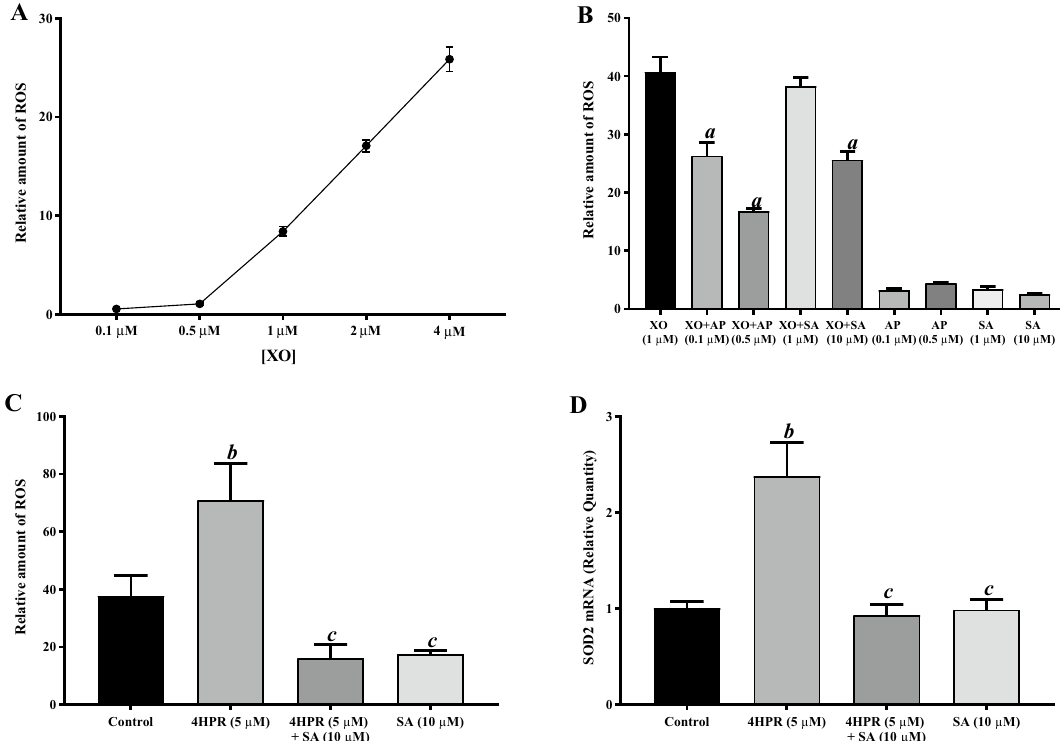
Figure 5. Fenretinide-induced ROS generation is blocked by pretreatment with sterculic acid in ARPE-19 cells. Fenretinide-induced ROS generation in ARPE-19 cells was measured in the presence or absence of pretreatment with sterculic acid (SA) and allopurinol using Amplex Red, as described under “Experimental Procedures”. ( A ) standard curve of superoxide formation at indicated xanthine oxidase concentrations. ( B ) inhibition of 1 μM xanthine oxidase-induced superoxide generation by SA and the ROS scavenger allopurinol. ( C ) Fenretinide- induced ROS generation in ARPE-19 cells is prevented by pretreatment with SA. ( D ) Fenretinide-induced SOD2 mRNA expression is prevented by pretreatment with SA. ARPE-19 cells were treated with 5 μM fenretinide (4HPR) for the indicated time, and total RNA preparations were analyzed by qPCR as described under “Experimental Procedures”. Intracellular ROS generation was measured using cell-permeable and nonfluorescent carboxy-H 2 DCFDA to fluorescent carboxy dichlorofluorescein (DCF) inside the cells. The values are mean ± SD of three independent experiments performed in triplicate. To test for significant differences between treatment groups, one-way analysis of variance (ANOVA) was used. In the graphs, ‘ a ’ indicates statistical significance difference between xanthine oxidase treated and xanthine oxidase treated with allopurinol or SA ( a p < 0.001), ‘ b ’ indicates statistical significance difference between untreated controls and fenretinide treated ( b p < 0.001), and ‘ c ’ indicates statistical significance difference between fenretinide treated and fenretinide treated + SA, or SA alone ( c p <